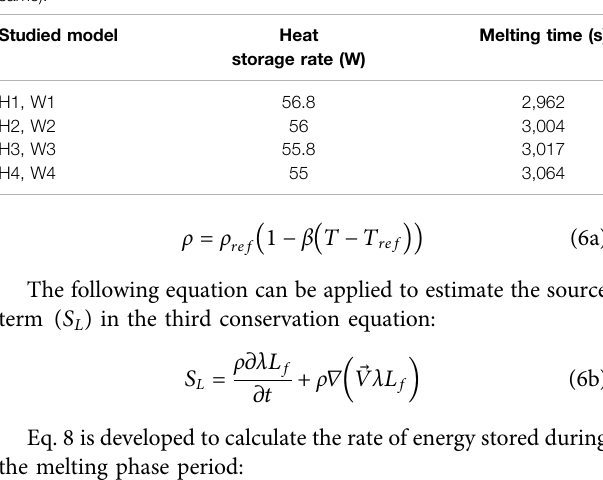
TABLE 4 | The total heat storage rates and the melting times for various dimensions of the T-shaped fi n ’ s head (the sizes of the fi n ’ s body are the